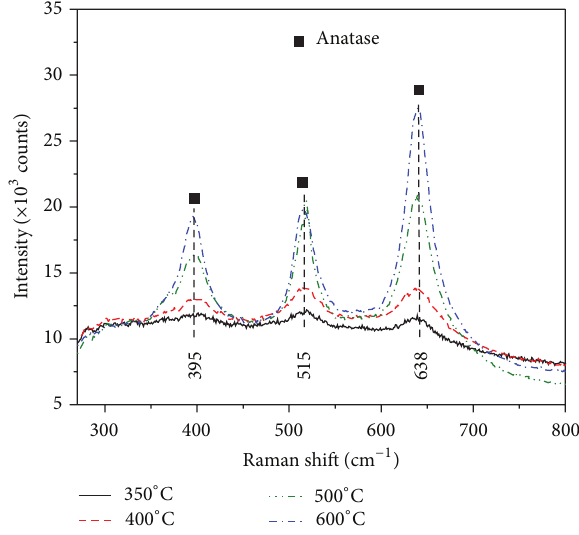
Figure 3: Raman spectra of ITO-TiO 2 core-shell nanostructures annealed between 350 and 600 ∘